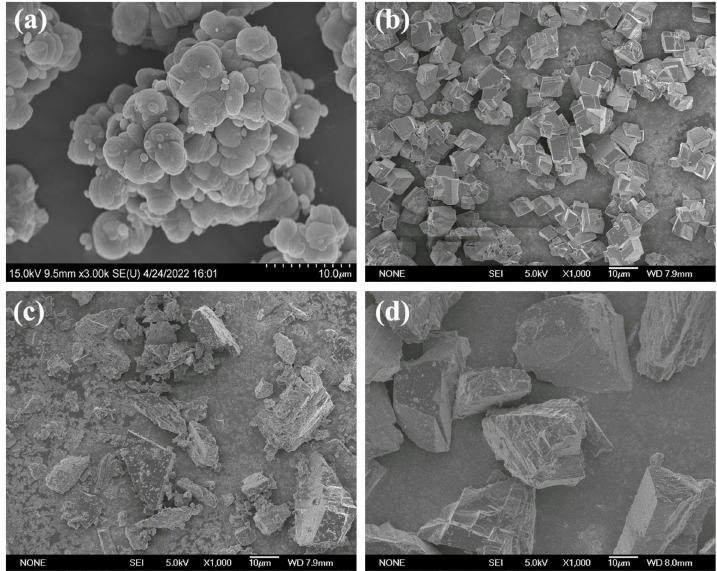
Figure 3. SEM images of four calcium carbonate precursors: ( a ) vaterite-type precipitated calcium carbonate; ( b ) calcite-type precipitated calcium carbonate; ( c ) <500 mesh ground calcite carbonate; and ( d ) 400–500 mesh ground calcite